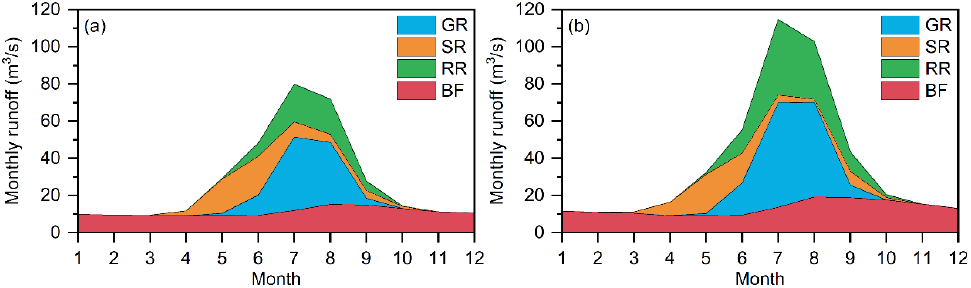
Figure 11. Monthly variation of simulated runoff components. ( a ) 1971~2000; ( b ) 2001~2020.